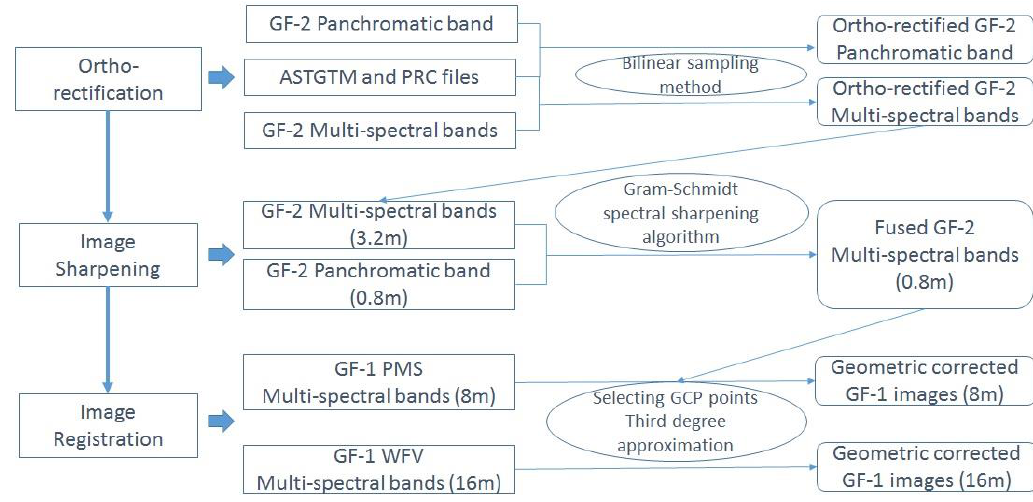
Figure 3. Flowchart of image pre-processing.